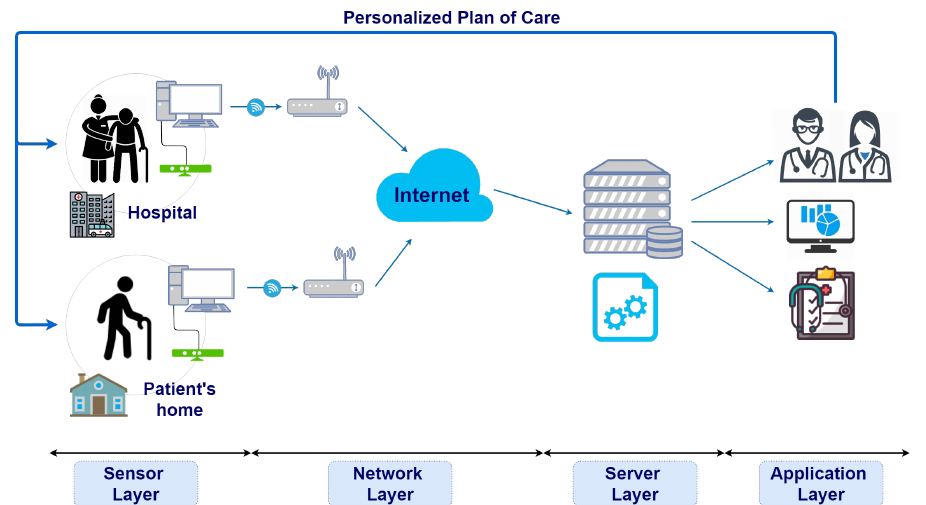
Figure 1. Architecture of remote-monitoring validation engineering system (ReMoVES). Each layer is depicted in the corresponding